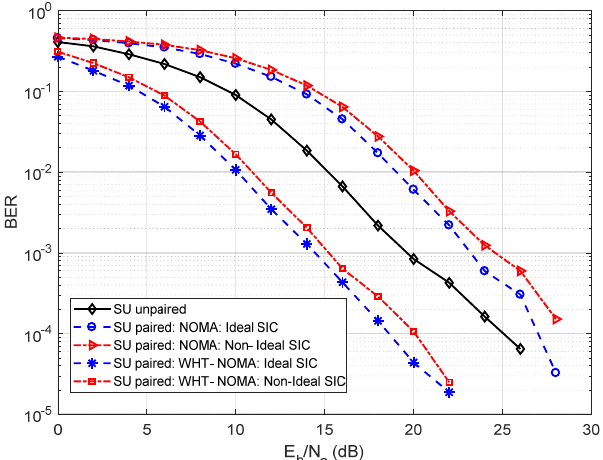
Figure 6. BER performance using BPSK modulation; NOMA vs. WHT–NOMA, power allocation: SU (SCU) = 0.4 and MU (SEU) = 0.6.